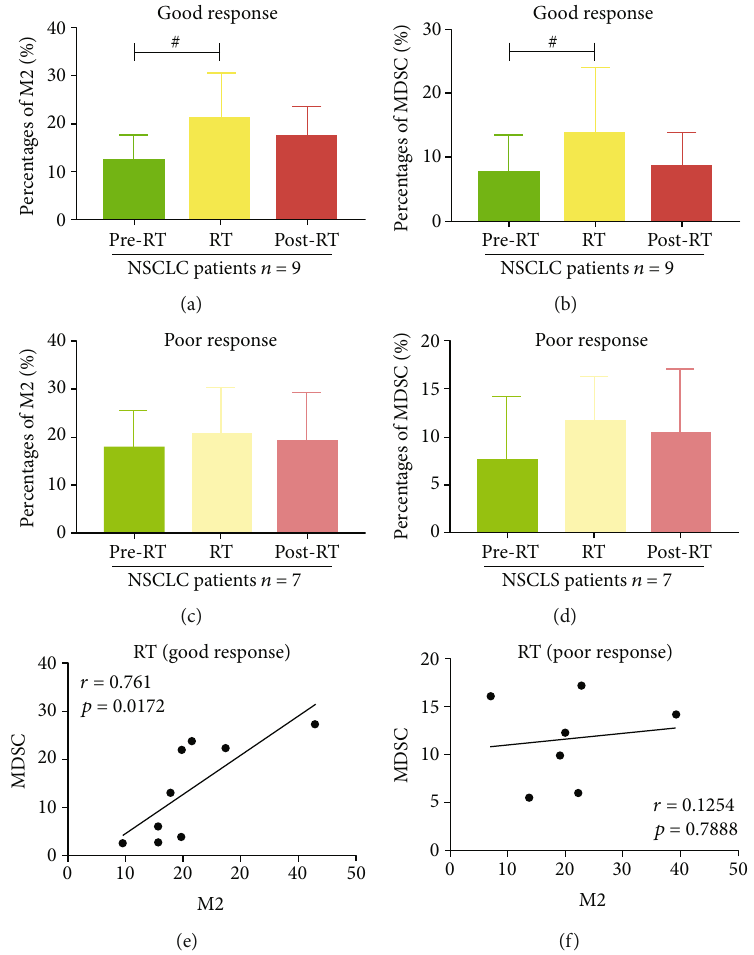
Figure 5: The therapeutic response role of the percentages of MDSCs and CD68 + CD163 + M2-like macrophages of NSCLC patients. (a, c) The percentages of CD68 + CD163 + M2-like macrophages of good and poor groups in pre-RT, RT, and post-RT. (b, d) The frequencies of MDSCs of good and poor in pre-RT, RT, and post-RT. (e, f) The correlation between MDSCs and CD68 + CD163 + M2-like macrophages of NSCLC patients of the good and poor groups during radiotherapy. # p < 0 : 05 . Data were analyzed by Pearson ’ s correlation test. The bars denote mean ± SD